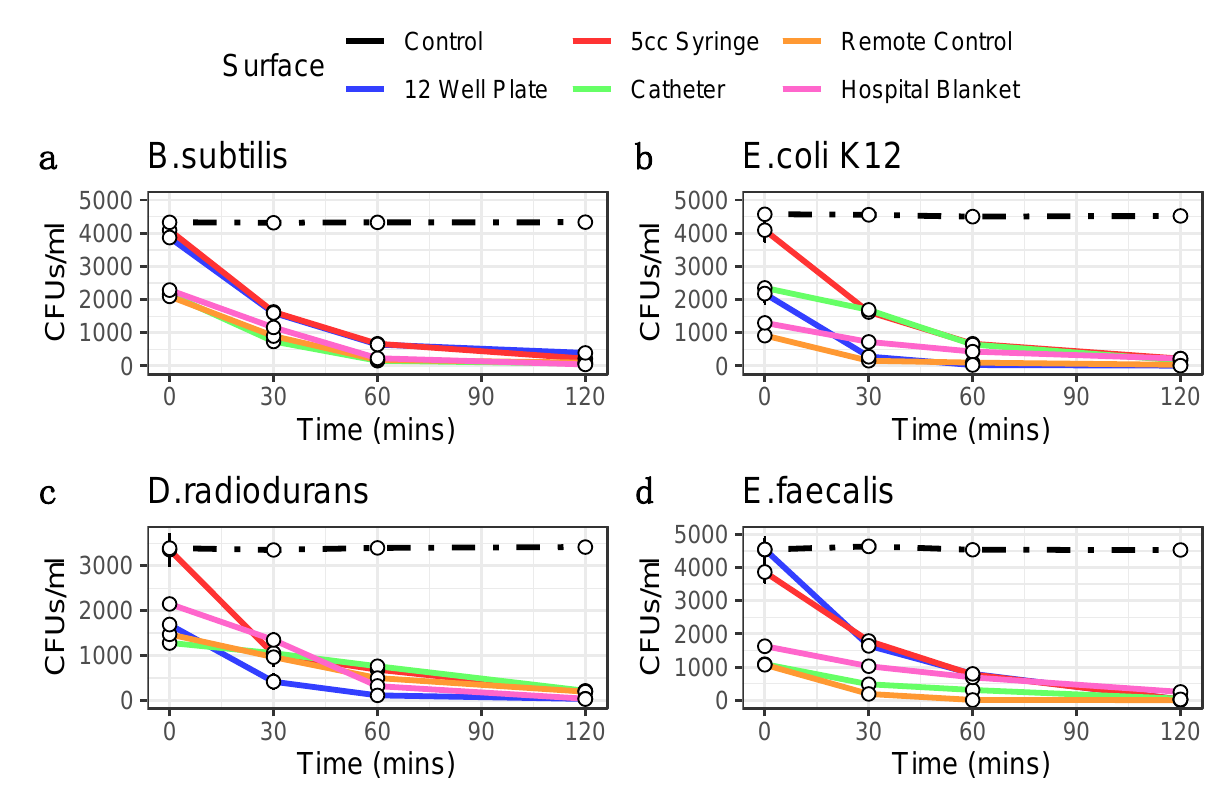
Figure 1. Ozone Kill Curves indicate ozone treatment reduces bacterial load. 1 mL of bacteria for taxa B. subtilis ( a ), E. coli K12 ( b ), D. radiodurans ( c ), and E. faecalis ( d ) were pipetted into wells of 12 well plates and 100 uL was collected at each time point for plating. 100 uL of bacteria were pipetted inside 5 cc syringes, inside catheters, onto remotes, and onto hospital blankets in triplicates and swabbed for 3 min at each time point for plating. Colony forming units were then counted following plating and 12 h incubation. CFUs are converted into CFUs/mL ( y -axis). Error bars represent standard error of the mean. Controls are indicated as black lines. Ozone treatment ( x -axis) is at 20 ppm.